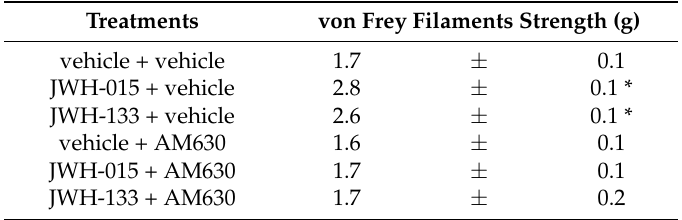
Table 1. Reversion of the antiallodynic effects of JWH-015 and JWH-133 (3 mg/kg; subcutaneously administered) by the intraperitoneal administration of 1 mg/kg of AM630 in db/db